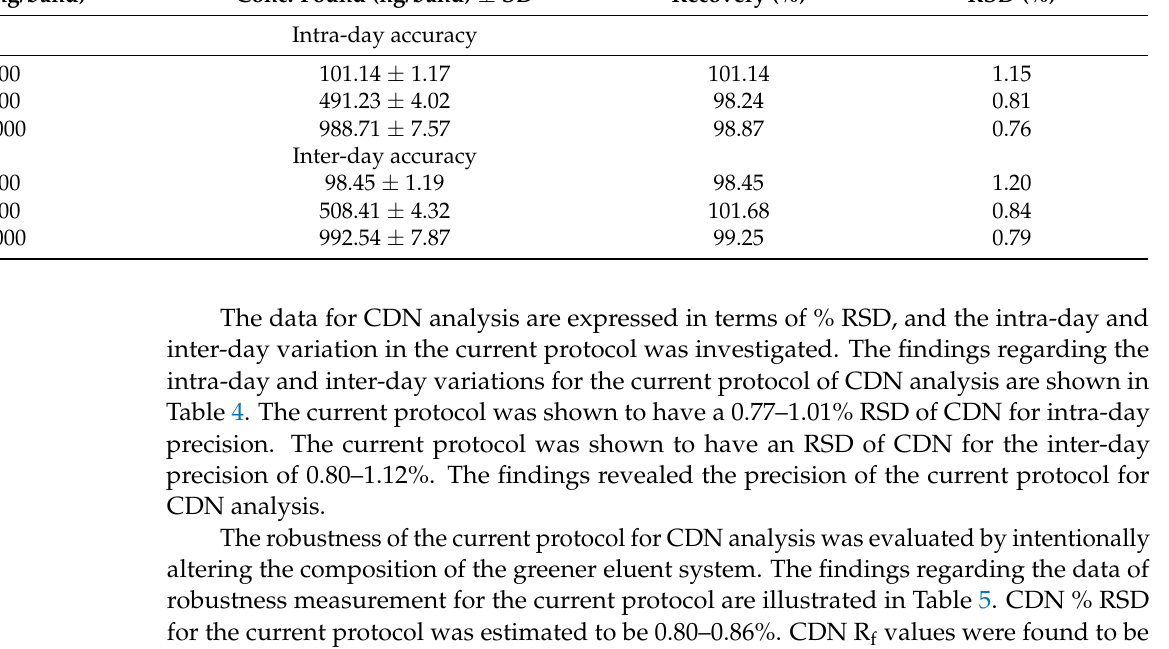
Table 3. Intra-day and inter-day accuracy data of CDN for current protocol (mean ± SD; n = 6). Conc.